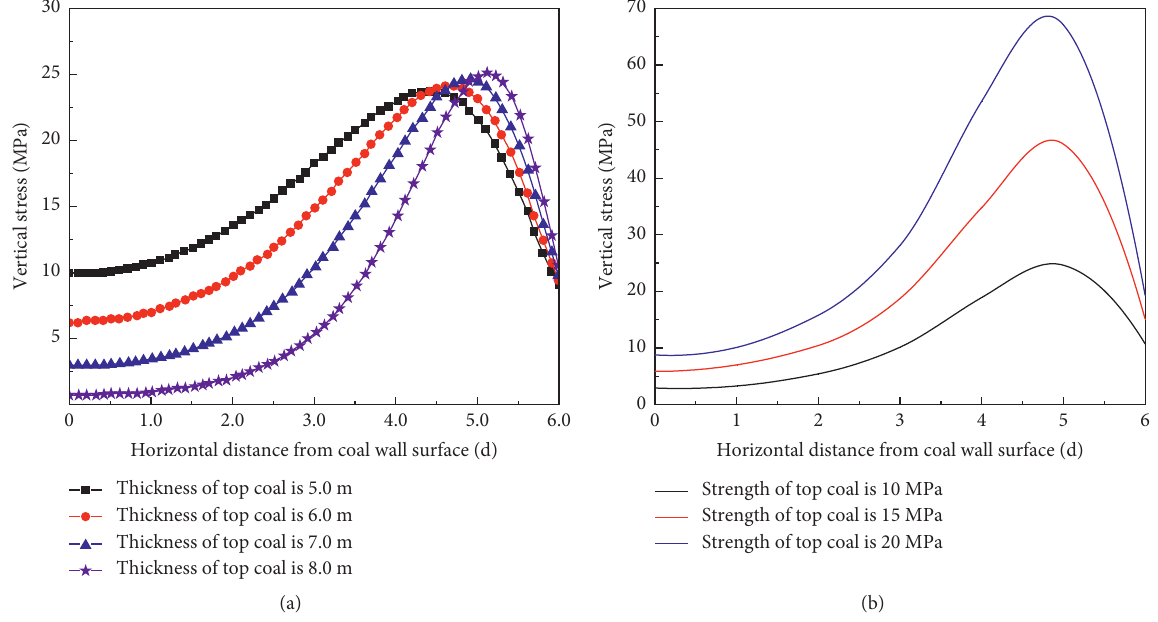
Figure 4: The influence of top coal thickness and strength on the stress distribution of coal seam. (a) Top coal thickness; (b) top coal